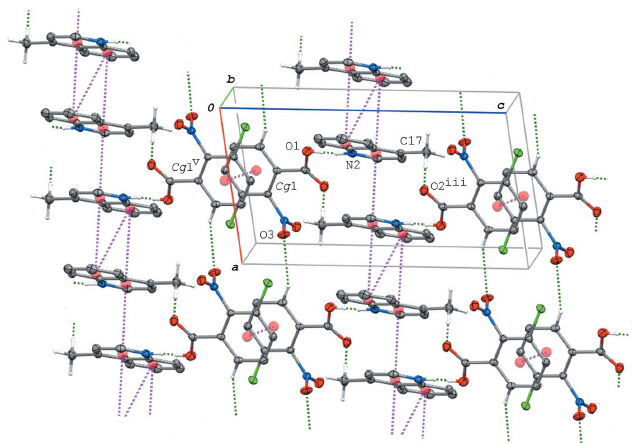
Figure 9 A packing diagram of (IV), showing the layer structure formed via the (cid:2) – (cid:2) interactions (magenta dashed lines), and the O—H (cid:2)(cid:2)(cid:2) N/O (cid:2)(cid:2)(cid:2) H—N and C—H (cid:2)(cid:2)(cid:2) O hydrogen bonds (green dashed lines). Except for the methyl group, H atoms not involved in the hydrogen bonds are omitted for clarity. Cg 1 is the centroid of the C1–C6 ring. [Symmetry codes: (iii) (cid:3) x + 1, (cid:3) y , (cid:3) z + 1; (v) (cid:3) x + 1, (cid:3) y + 1, (cid:3) z + 1.]